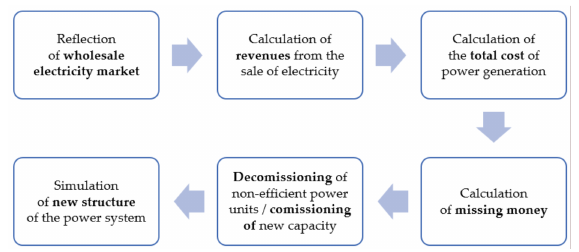
Figure 3. Calculation procedure under the EOM